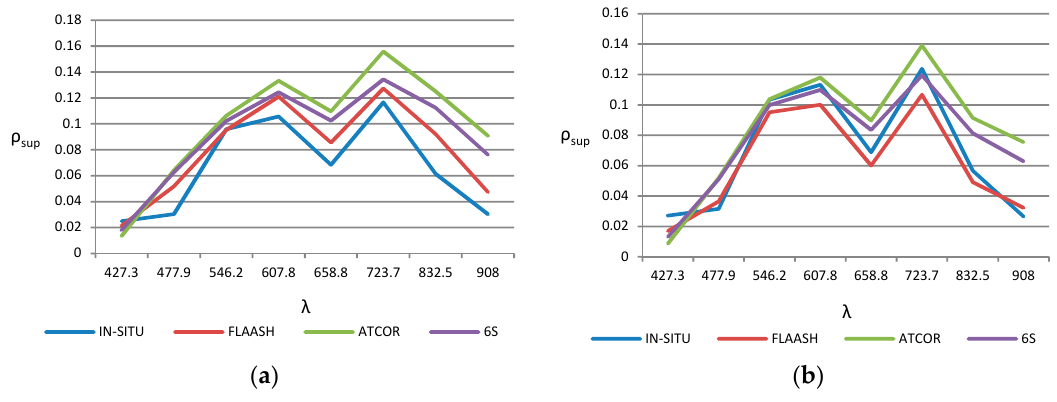
Figure 7. Spectral reflectivity signatures in the nearest coastal shallow water sites (points number 1 from A to G), as shown in Figure 2: ( a ) Coast point 1; ( b ) Coast point 4; ( c ) Coast point 5; ( d ) Coast point 8; ( e ) Coast point 10 and; ( f ) Coast point 12.